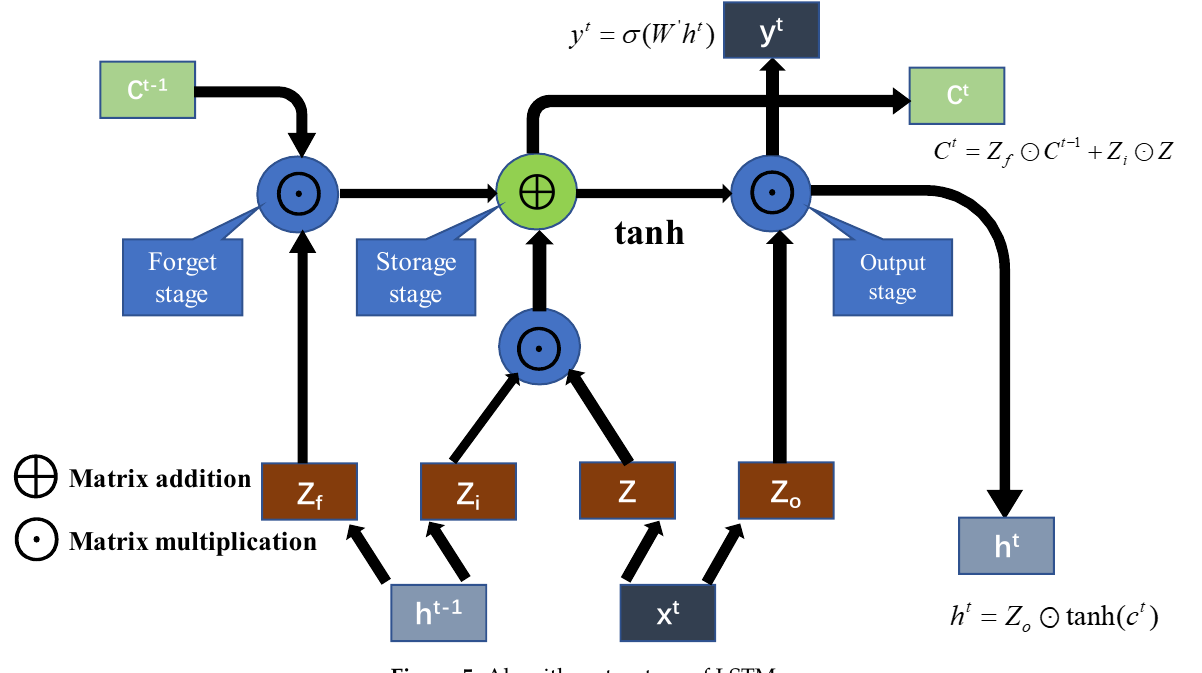
Figure 5. Algorithm structure of LSTM.